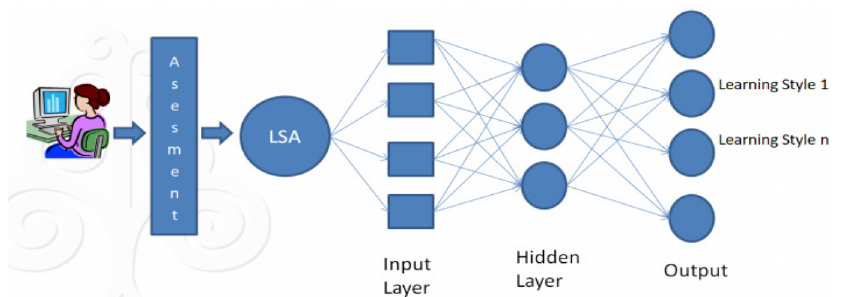
Figure 4. Architecture neural network for e-learning